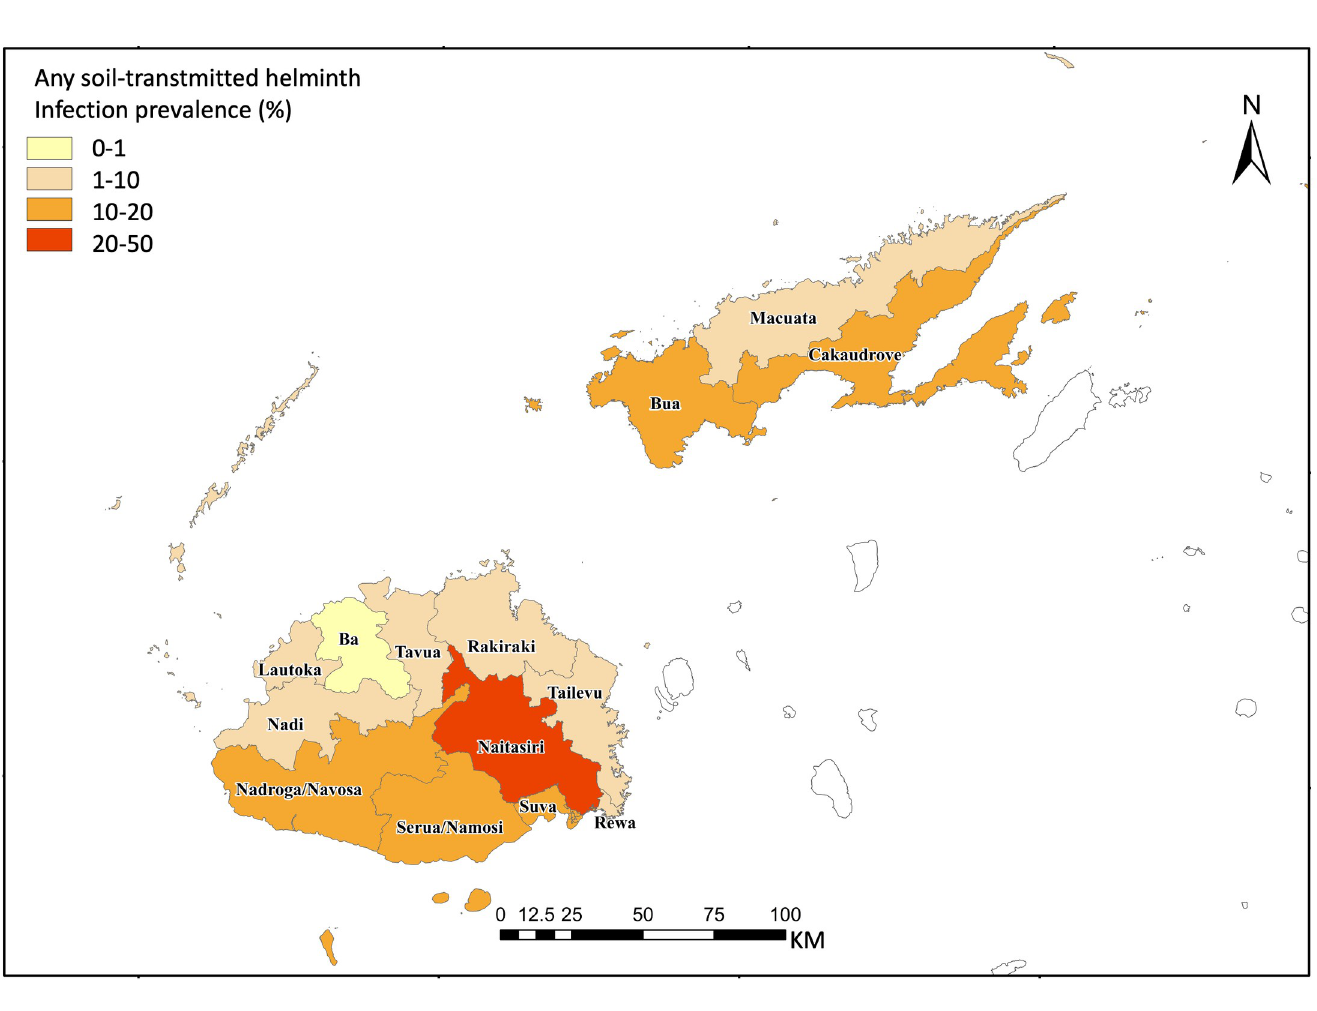
Fig 3. Sketch map of sub-Divisional “any STH” prevalence levels in the Western, Central, and Northern � Divisions, 2014–2015 � Except the Taveuni sub-Division.